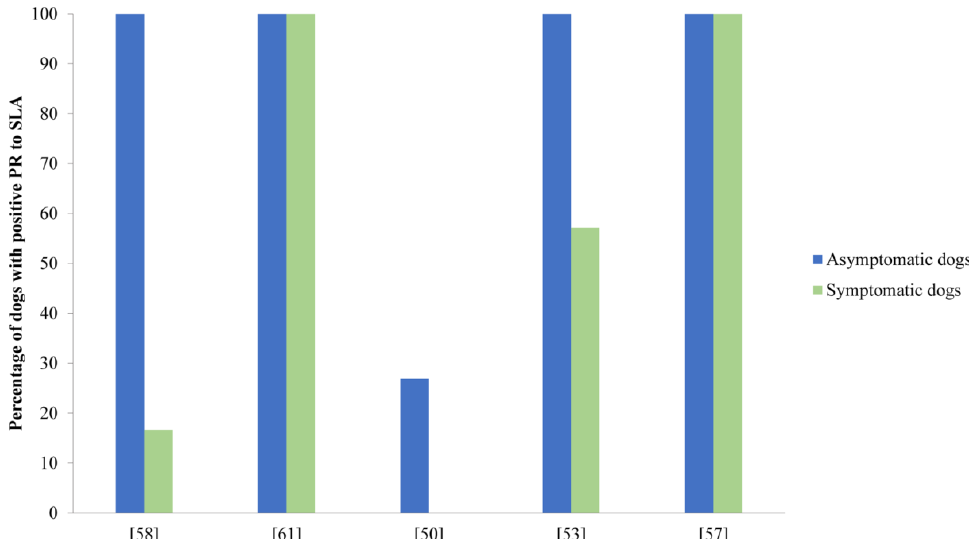
Figure 2. Graphical representation of the percentage of dogs who exhibited positive lymphoproliferative response to SLA. In this figure, all studies that specified the number of dogs who gave a positive proliferative response have been included. PR: proliferative response; SLA: soluble Leishmania